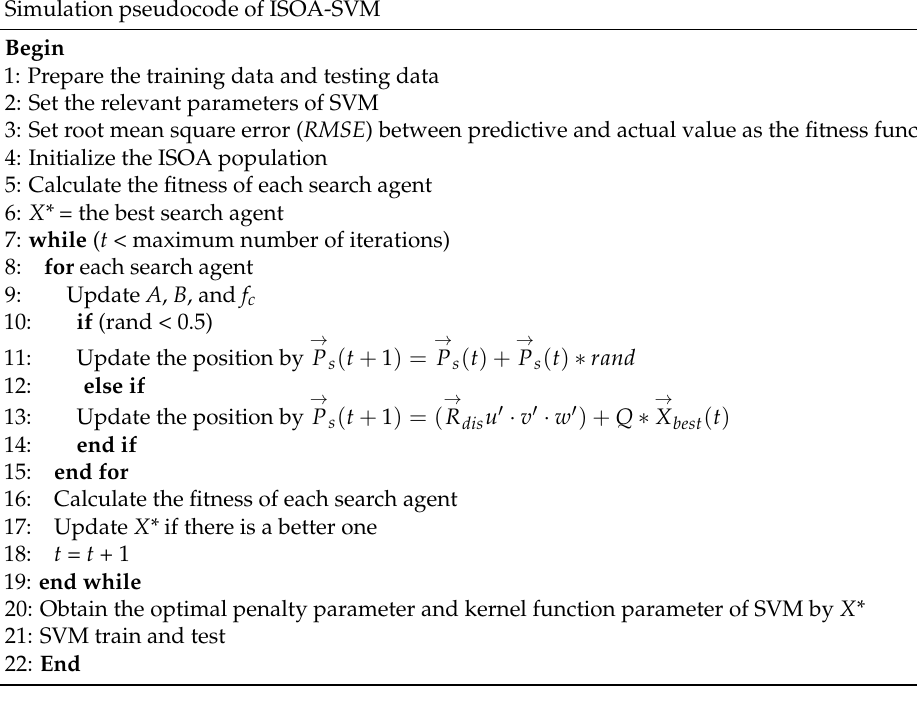
Table 4. Simulation pseudocode of ISOA-SVM. Simulation pseudocode of